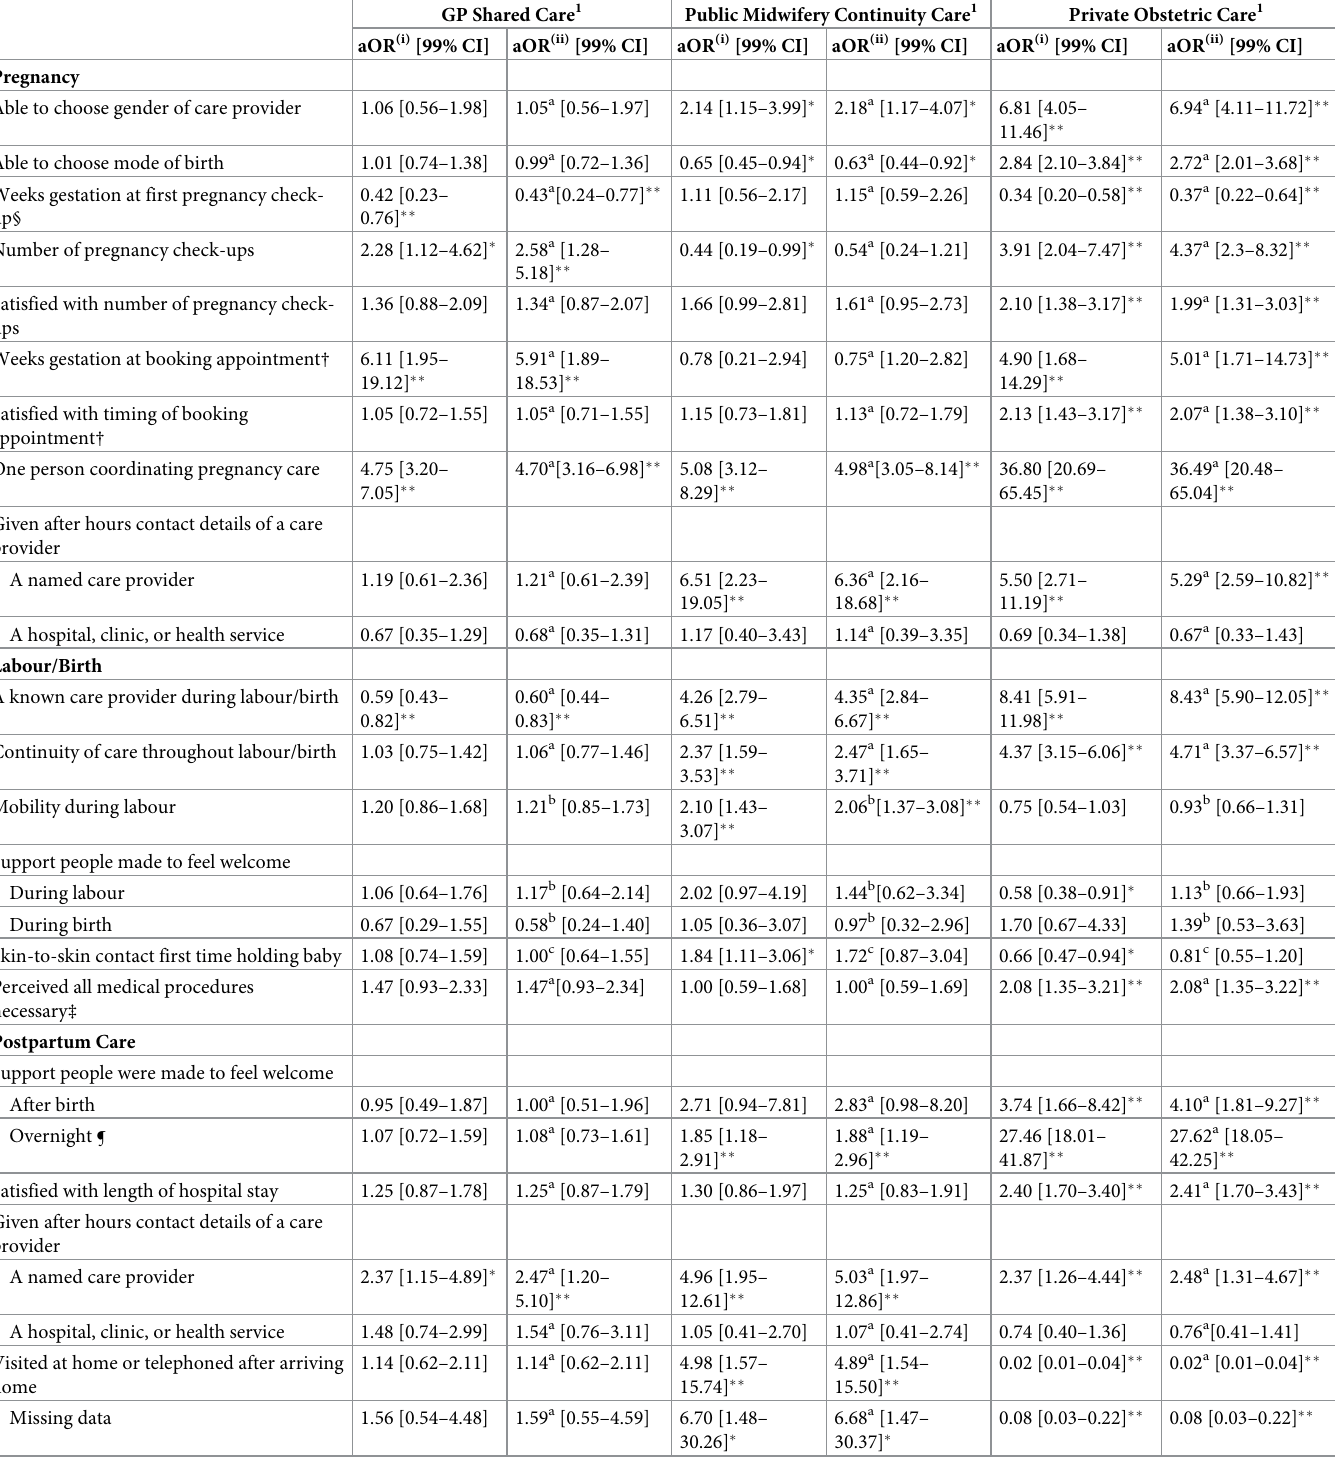
Table 6. Adjusted odds ratios for maternal experiences during pregnancy, labour/birth, and postpartum care by maternity model of care, adjusting for (i) sociode- mographic characteristics, reproductive history, and (ii) with additional adjustment for relevant clinical